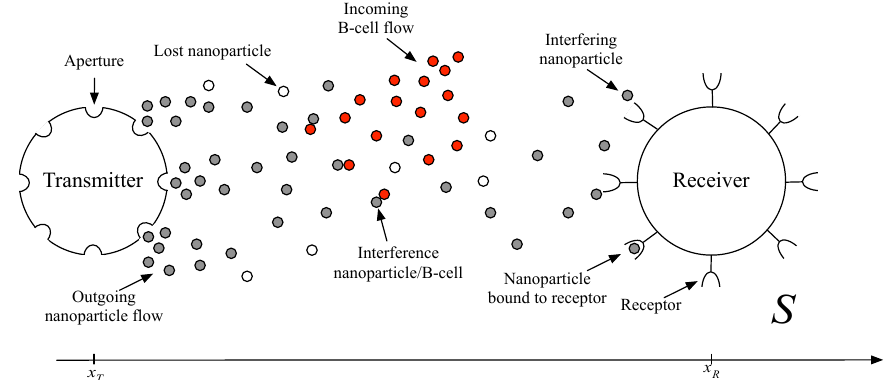
Figure 1. End-to-end physical model in the biological space S , linking a transmitting nanomachine to a receiver. One or more fluxes of nanoparticles are emitted by the transmitter and diffuse along the propagation channel. The presence of B-cells causes a reduction of the nanoparticle concentration able to reach the receiver, modeled as fixed nodes in the nanonetwork. Moreover, lost and interfering nanoparticles can provide errors during the reception process ( i.e. , no reception and missing reception,